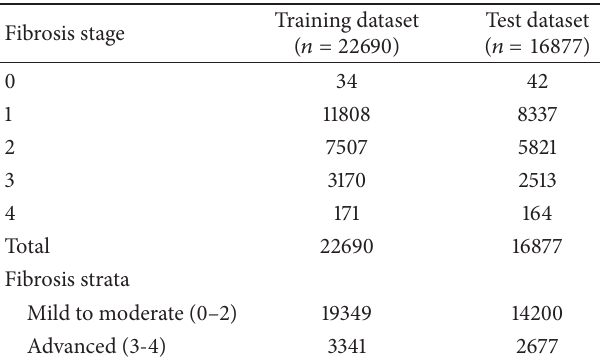
Table 1: Fibrosis records and strata in the data